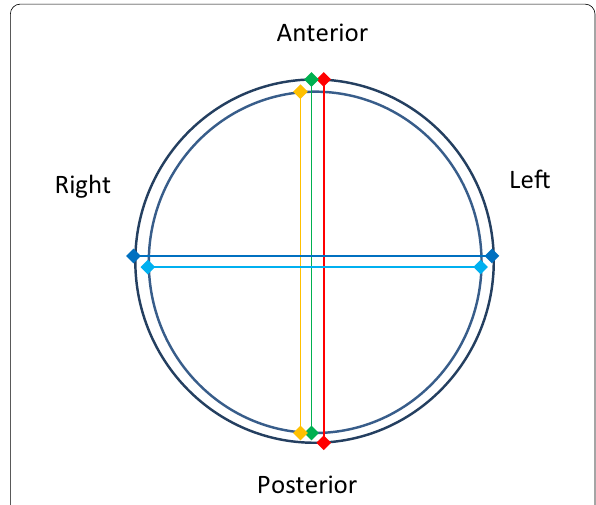
Fig. 1 Illustration of a transverse view of an abdominal aortic aneurysm with the participant in the supine position. Figure shows ideal placement of callipers for ITI ( / ), LETLE ( ), OTO ( / ) in both anterior–posterior and transverse direction. OTO: outer-to-outer; LETE: leading edge-to-leading edge; ITI: